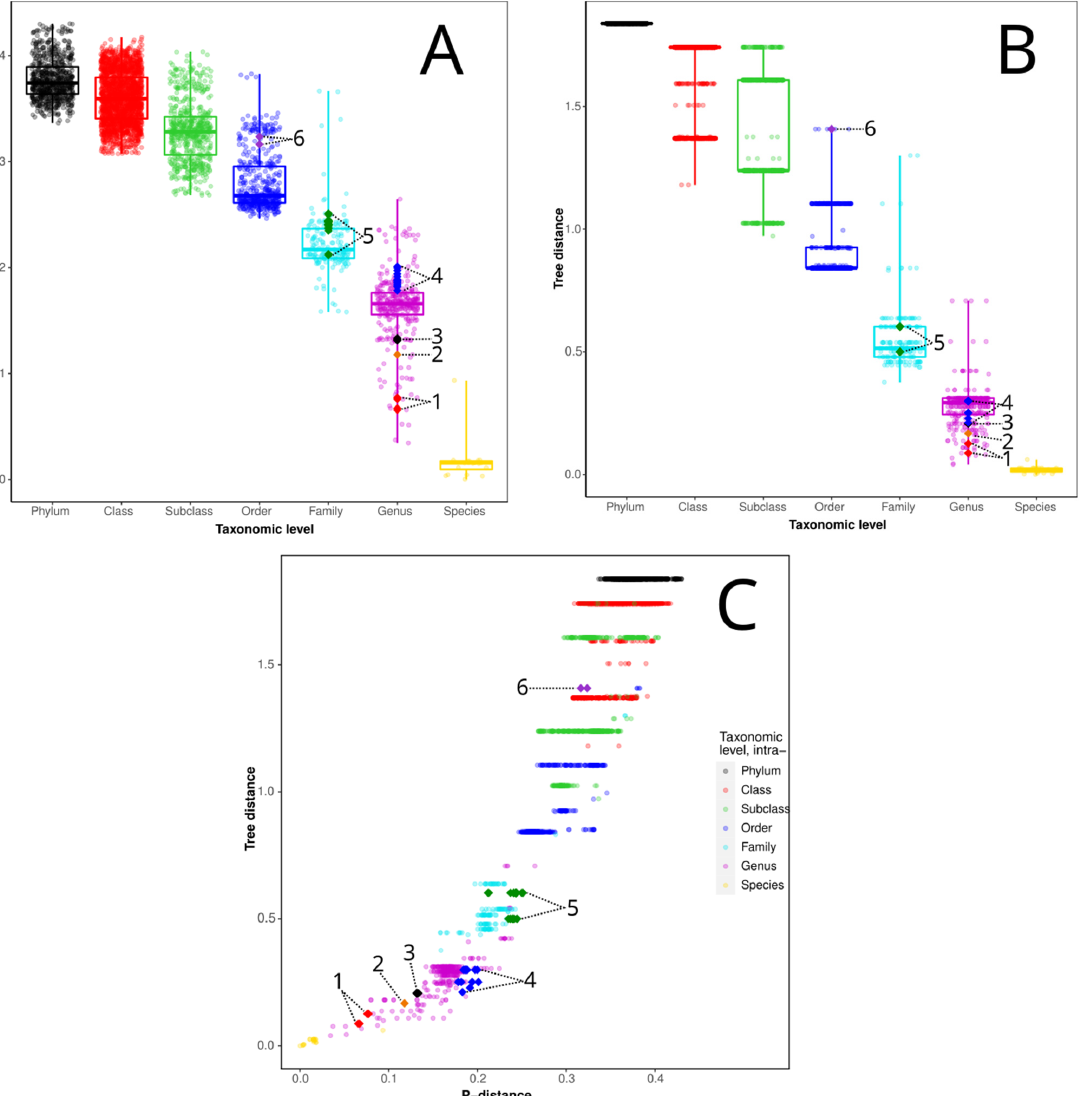
Figure 4. Distribution of p-distances ( A ), tree-based distances ( B ), and dependence of ultrametric tree-based distances from p-distances ( C ) by taxonomic levels according to adjusted sample taxonomy. Coloured diamonds indicate distances between selected groups: 1—between Glossiphonia spp. and Baicaloclepsis spp.; 2—between Piscicola geometra and Codonobdella sp.; 3—between Acanthobdella peledina and Paracanthobdella livanowi ; 4—between samples of Eisenia nordenskioldi ; 5—between species of families Hirudinidae and Haemopidae; 6—between samples of combined family Naididae (including